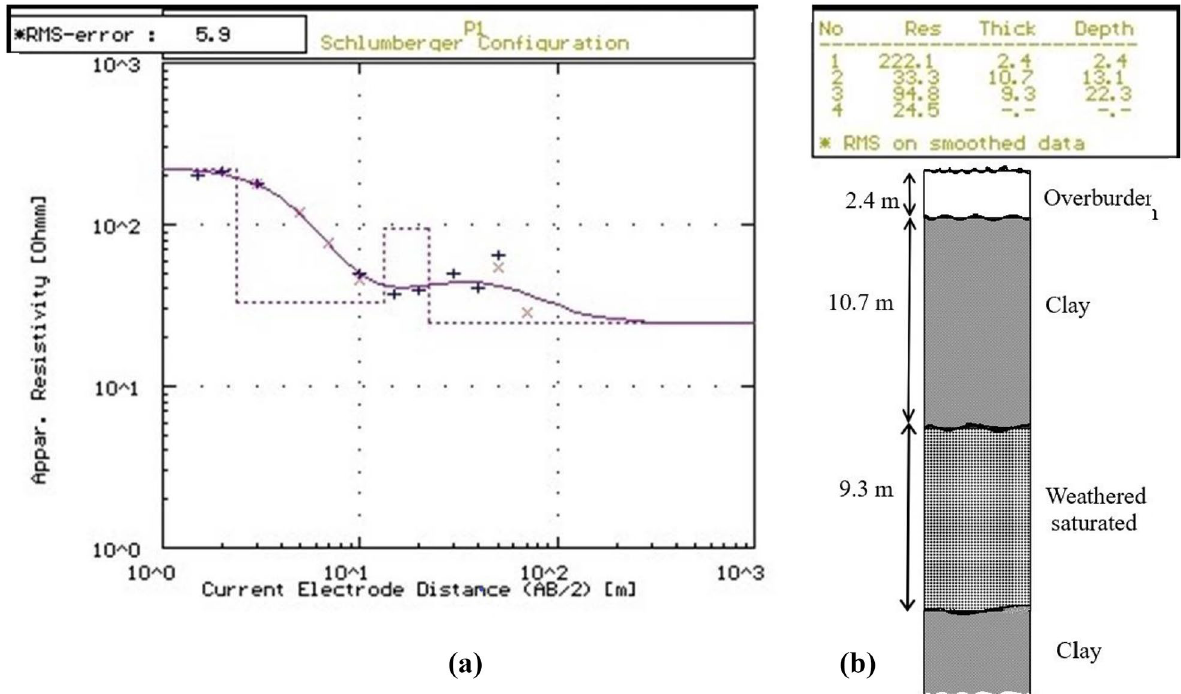
Fig. 4 a Curve matched from RESIST software for P1, b Geological profile for P1